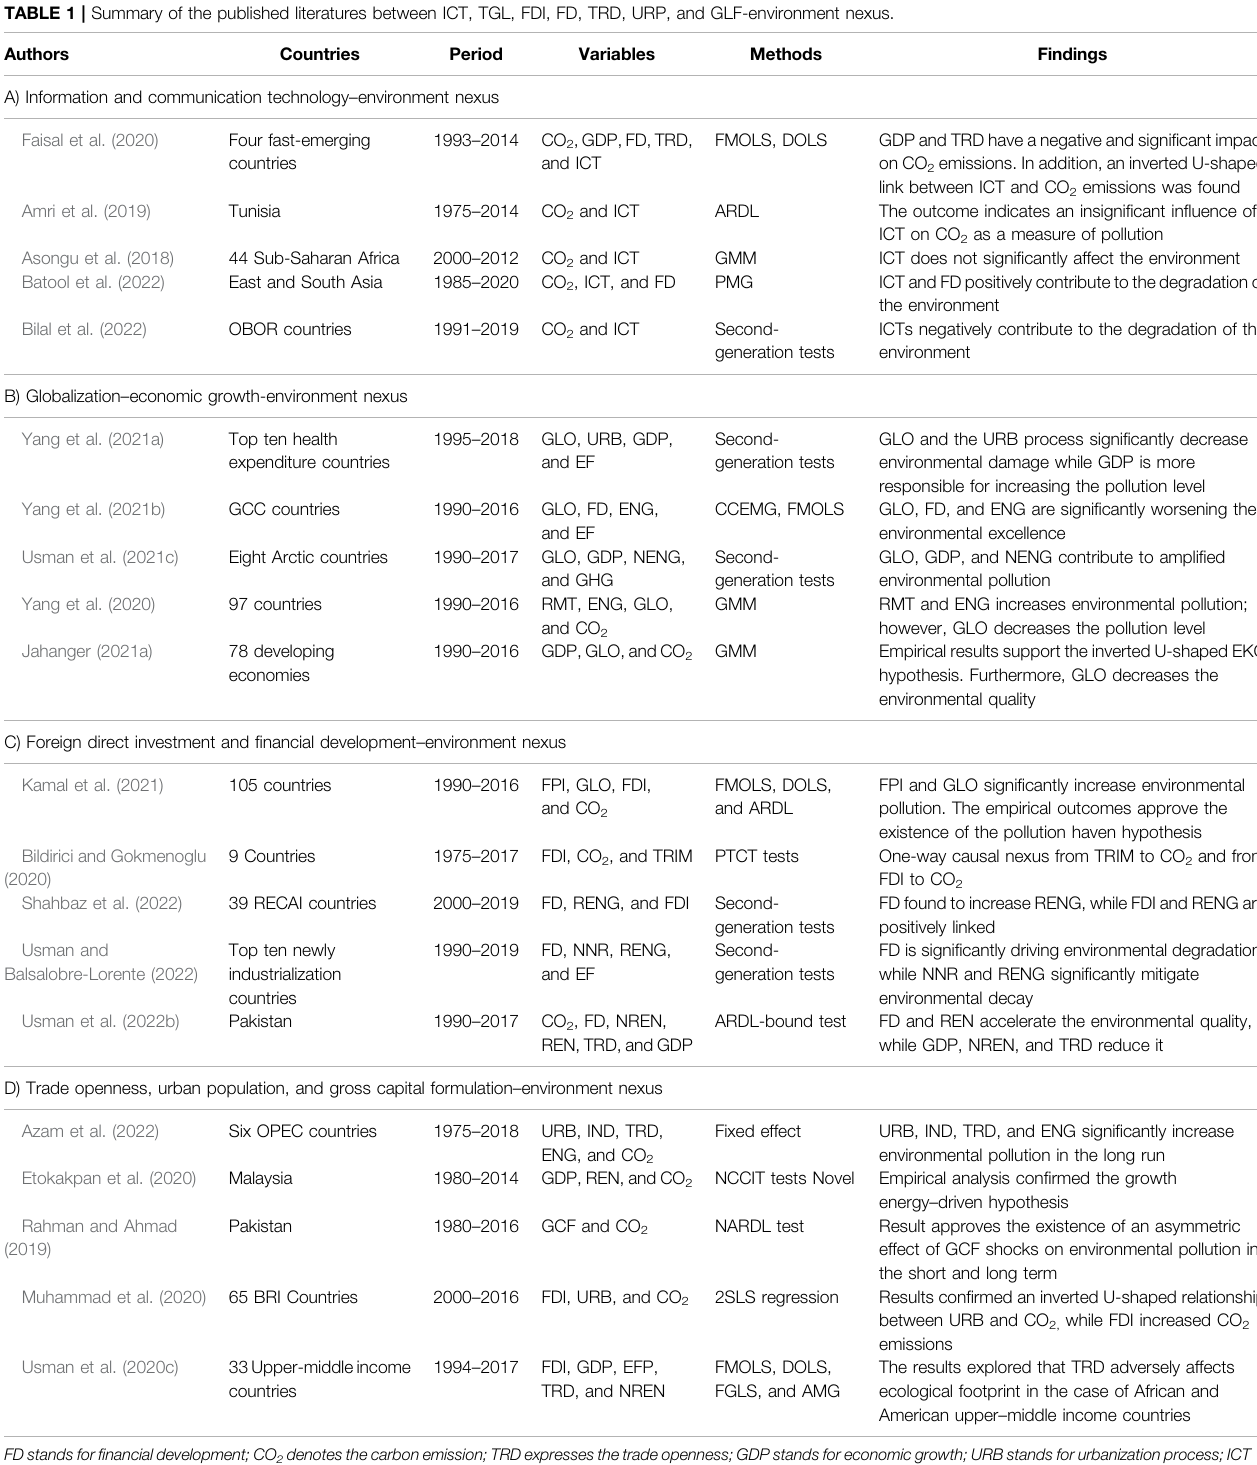
TABLE 1 | Summary of the published literatures between ICT, TGL, FDI, FD, TRD, URP, and GLF-environment